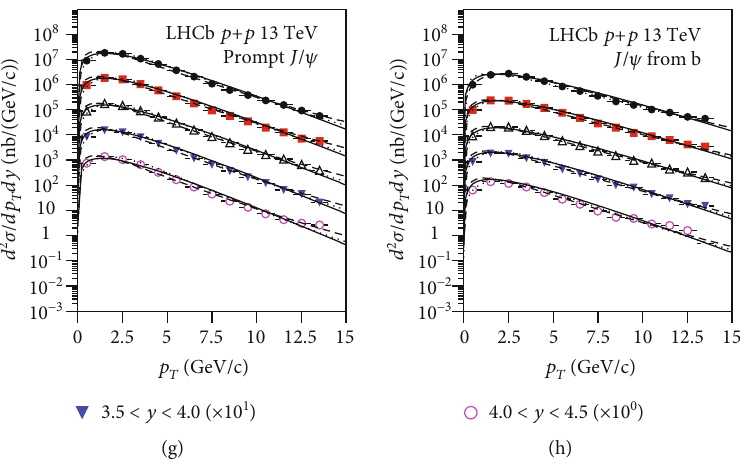
dy , of J / ψ in di ff erent production modes in (a, b) p + Pb and (c – h) p + p collisions at (a, b) 5, Figure 2: Transverse momentum spectra, d 2 σ / dp T (c, d) 7, (e, f) 8, and (g, h) 13 TeV. The di ff erent symbols represent the experimental data measured by the LHCb Collaboration [19 – 22] in the rapidity intervals of (a, b) 1 : 5 < y < 2 : 0 , 2 : 0 < y < 2 : 5 , 2 : 5 < y < 3 : 0 , 3 : 0 < y < 3 : 5 , and 3 : 5 < y < 4 : 0 and (c – h) 2 : 0 < y < 2 : 5 , 2 : 5 < y < 3 : 0 , 3 : 0 < y < 3 : 5 , 3 : 5 < y < 4 : 0 , and 4 : 0 < y < 4 : 5 , and scaled by di ff erent amounts marked in the panels. The solid, dashed, and dotted curves represent our results fi tted by the Erlang distribution (Eq. (3)), the Hagedorn function (Eq. (4)), and the Tsallis-Levy function (Eq. (6)),